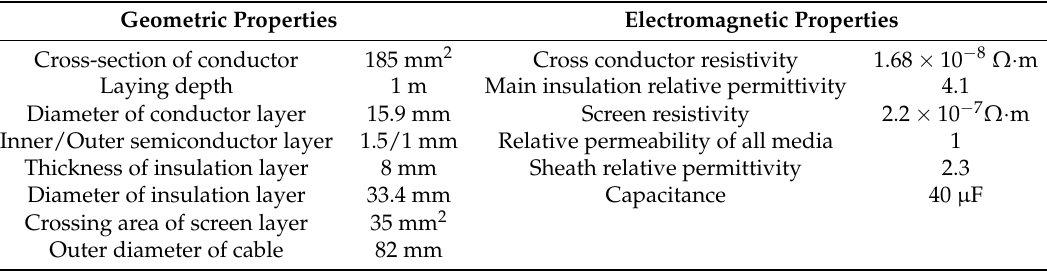
Table 2. Geometric configuration of 33 kV three-core (TC) submarine